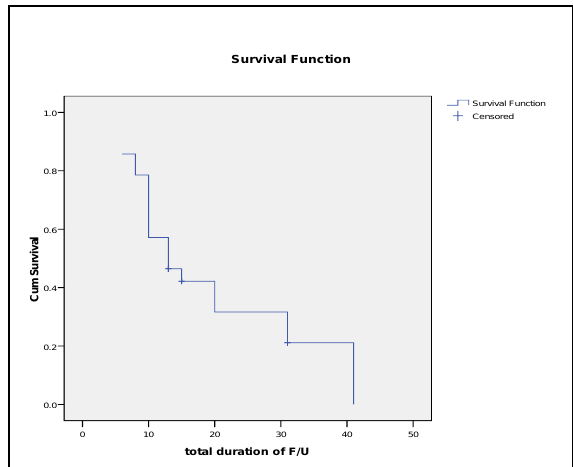
Figure 2: Kaplan-Meier curve: overall survival Cumulative survival probabilities were estimated using the Kaplan-Meier curve for second-line therapy in patients treated with Platinum/Taxanes in one arm and Platinum + other regimen in the other one. The